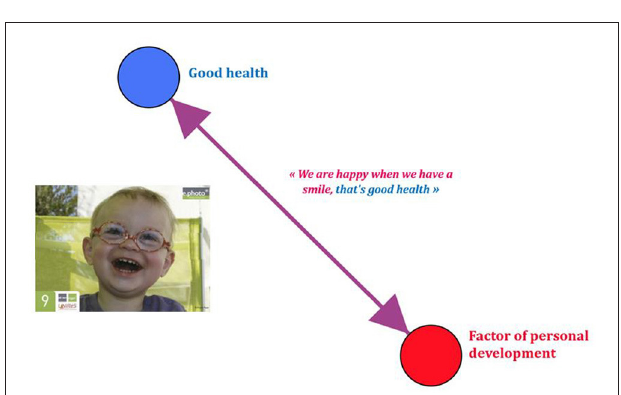
FIGURE 3 | Pictorial representation of simple conception systems e.Photoexpression © “good health” Gephi 9.2 ©